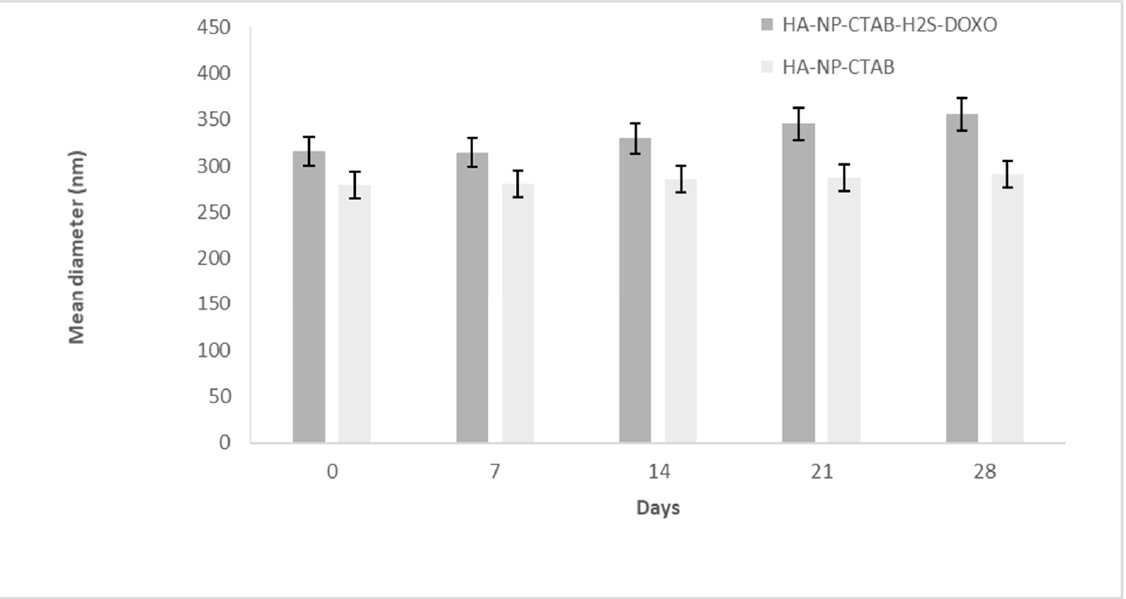
Figure 5. Mean diameter stability of HA-NP-CTAB-H 2 S-DOXO and HA-NP-CTAB over time (28 days). For NP-H 2 S-DOXO 3% PVP and NP-CTAB-H 2 S-DOXO with and without HA,